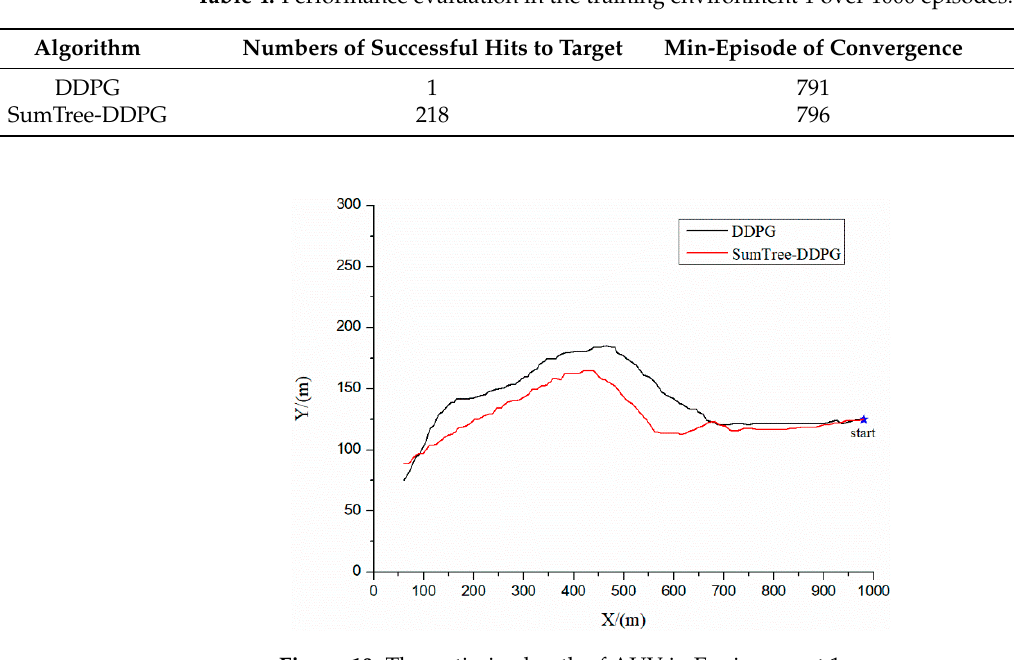
Table 4. Performance evaluation in the training environment 1 over 1000 episodes.